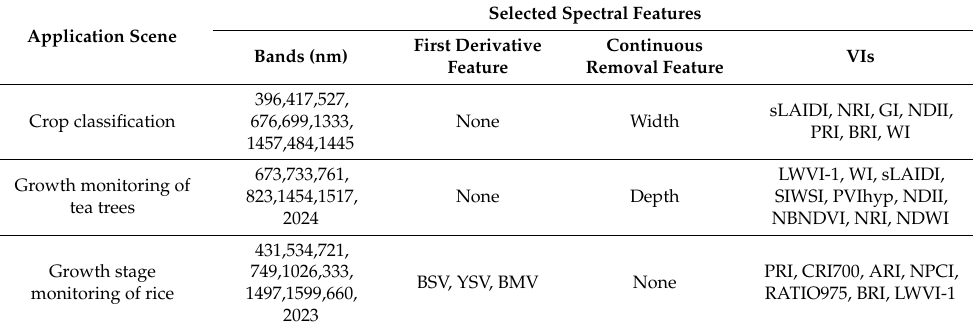
Figure 4. ( a ) Canopy spectra for di ff erent rice growth stages; ( b ) the results of band JM distance ISODATA clustering. The same color indicates the same cluster. Table 5. Selected spectral features for crop classification and growing status